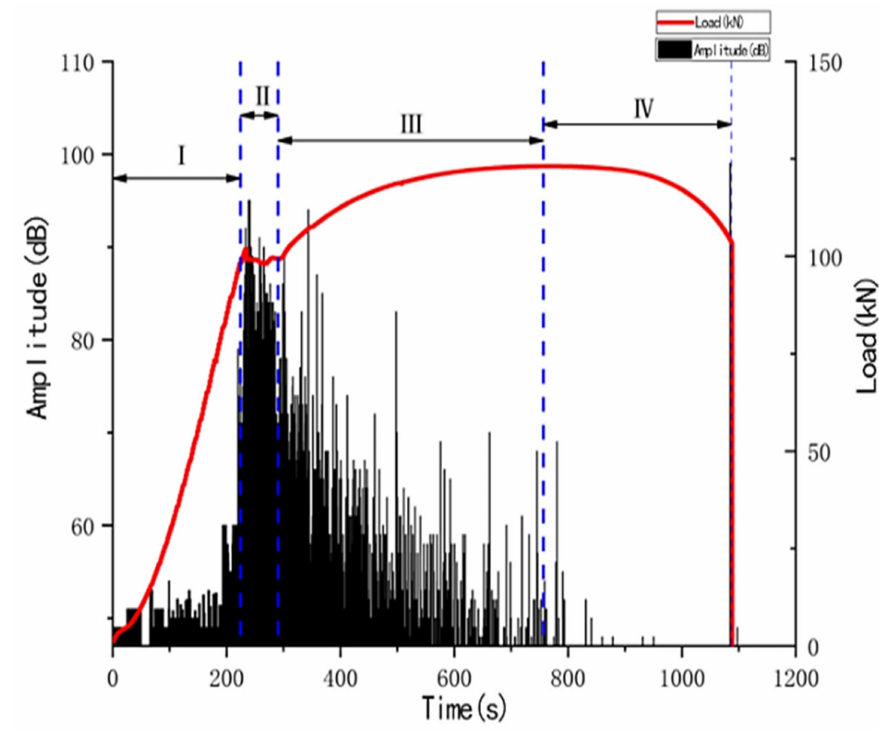
Figure 5. Signal amplitude parameters over time.